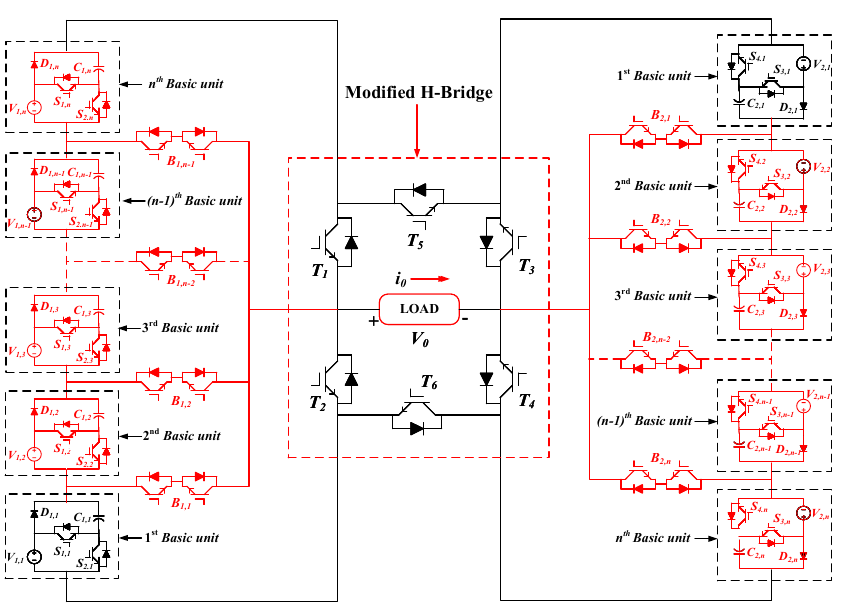
Figure 1. Circuit diagram of the Generalized Structure of the Multilevel Inverter (GSMLI). GSMLI : The GSMLI is achieved by including ( n − 1) basic units and ( n − 1) bidirec- tional switches ( B 1,1 , B 1,2 , . . . . . . , B 1,n − 1 ) to each side of the modified H-bridge, as shown in Figure 1 in red. Therefore, there are 2 n total basic units from which n basic units are connected to the left side of the modified H-bridge and the remaining n basic units are on the right side of the bridge.